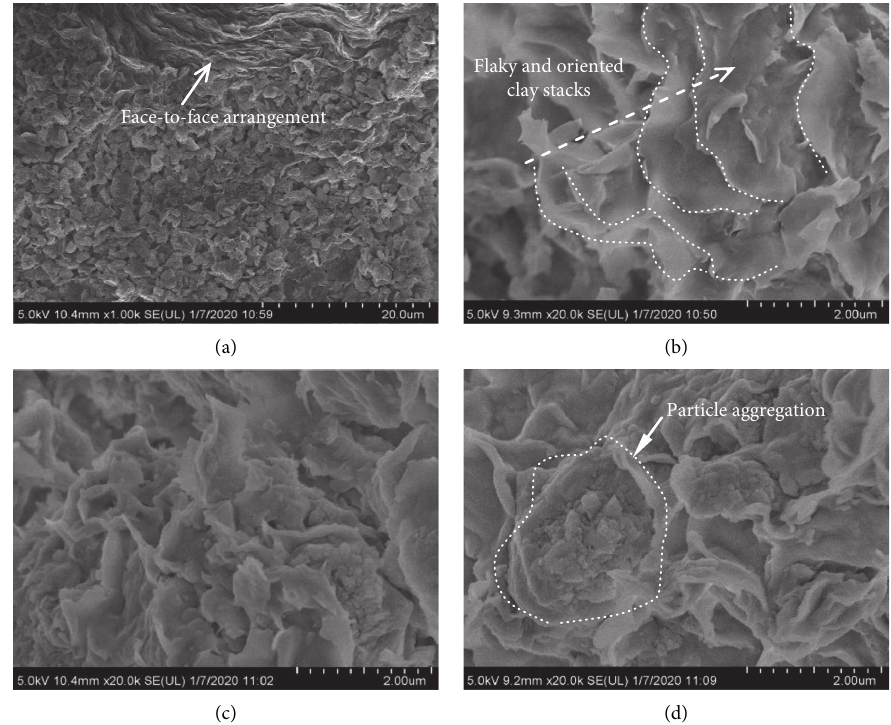
Figure 4: SEM images of bentonite: (a) sample after compaction ( × 1000); (b) DW ( × 20000); (c) 2.0Na-T ( × 20000); (d) 2.0Ca-T ( ×